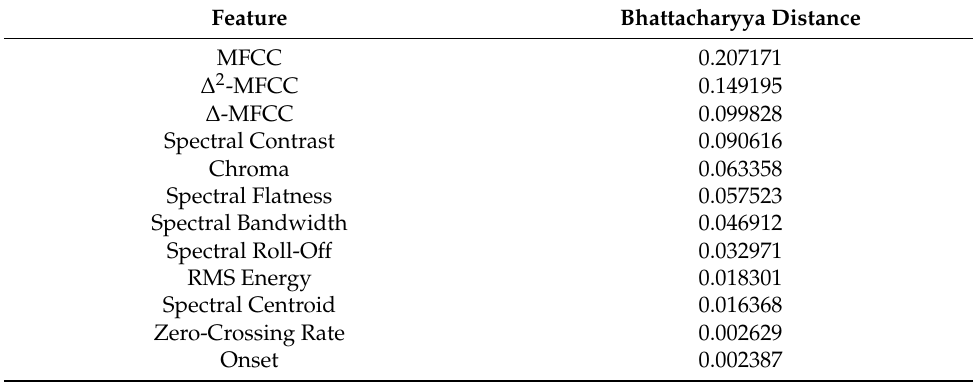
Table 4. Bhattacharyya distance of each